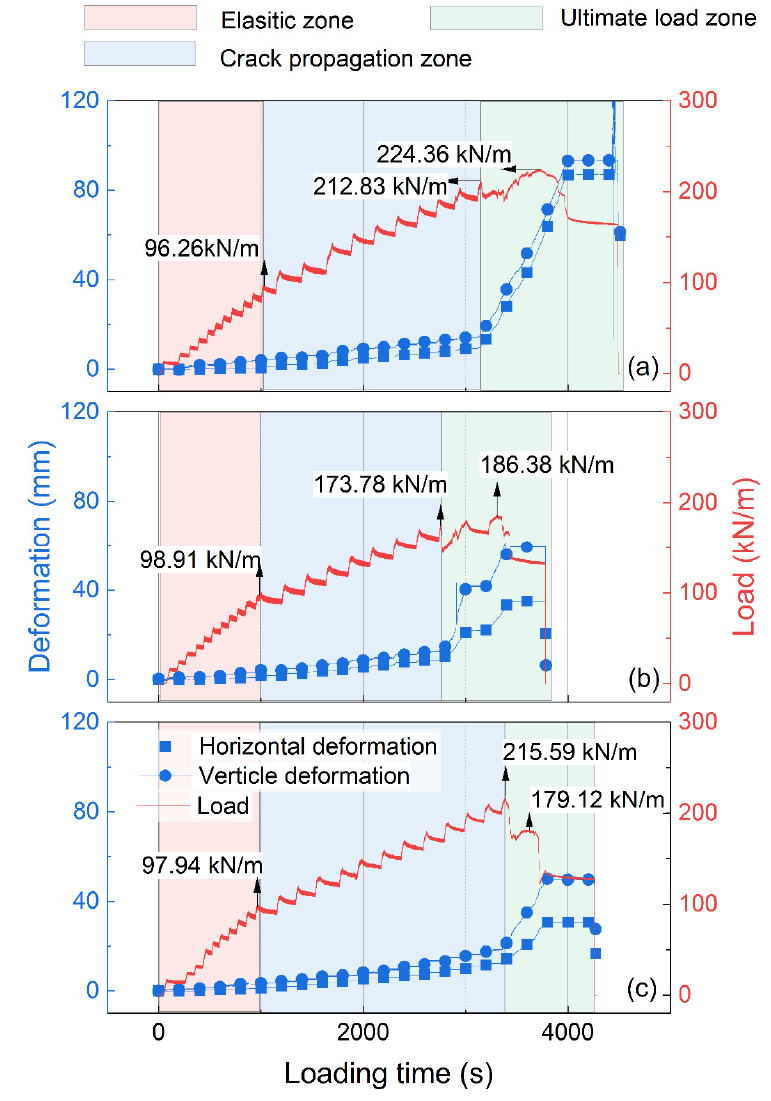
Figure 11. Evolution of force and displacement of a concrete pipe with inner diameter of 1500 mm when performing a three-edge bearing test, where ( a – c ) represents the pipe without wall loss, with 15-mm, and with 25–mm wall loss, respectively.